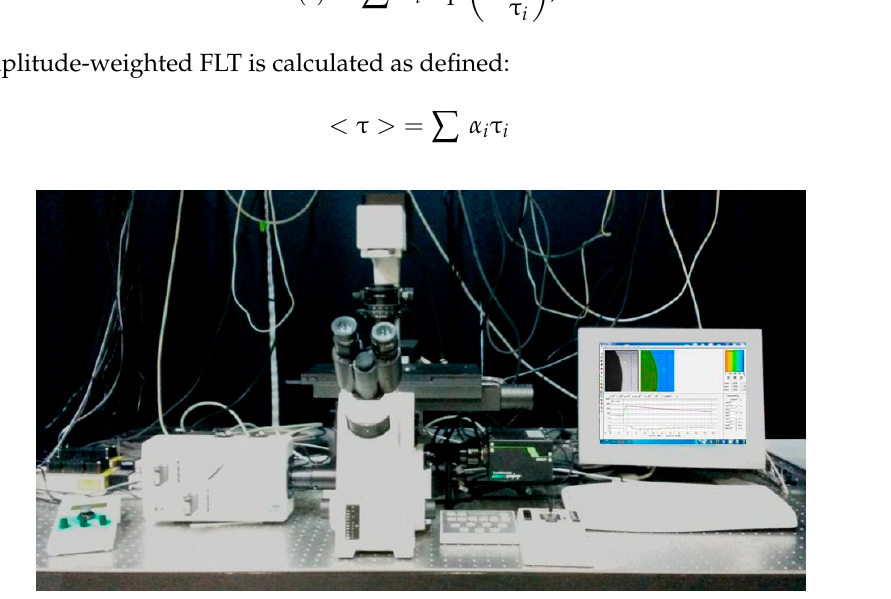
Figure 12. An image of the FLIM system.